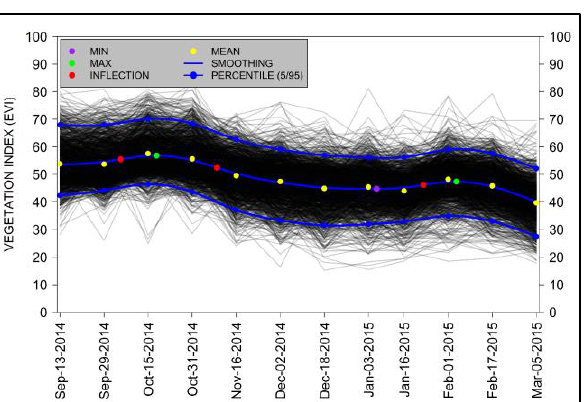
Figure 11. Chart of cluster 8.